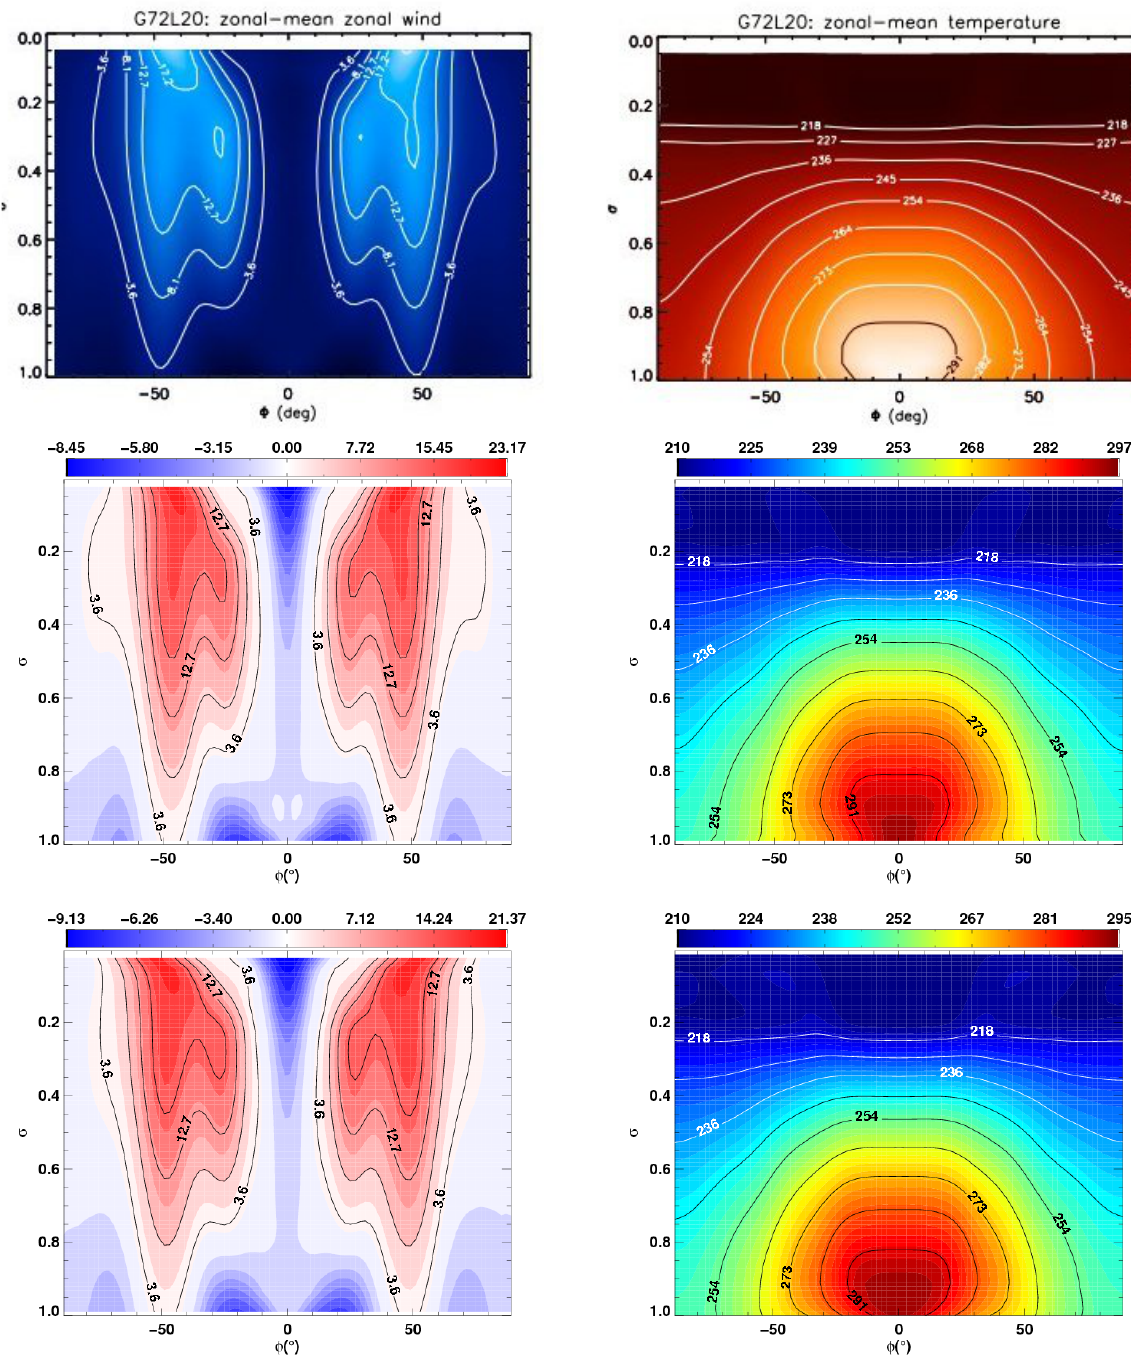
Figure 8. Figures showing, for the Earth-like test (Menou and Rauscher, 2009), the zonally averaged temperature and zonal wind. Top panels: temporally averaged results from grid-based model of Heng et al. (2011b) (reproduced by permission of Oxford University Press). Middle and bottom panels: temporally averaged results from this work using the ND and EG models, respectively (see Table 2 for explanation of model types).